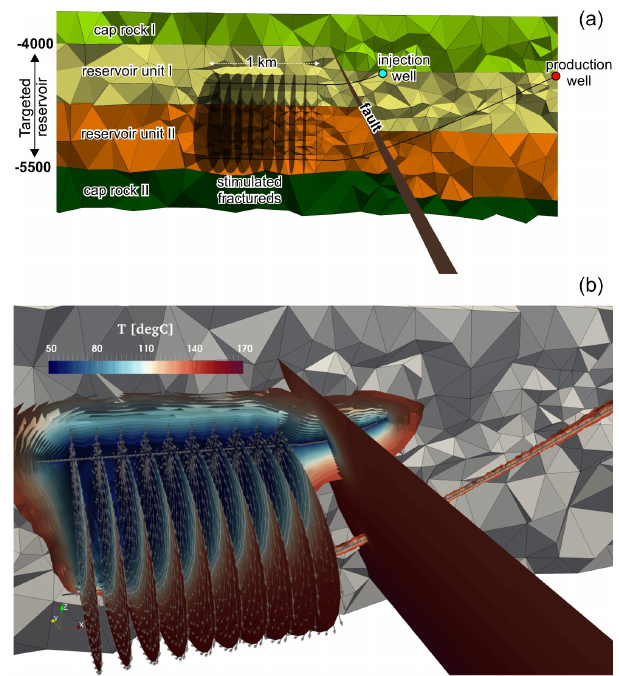
Figure 9. Problem formulation and results of the prototype of multi- fractured geothermal reservoir. Panel (a) shows the geometry and setup of the simulation and panel (b) the distribution of the temper- ature after approximately 100 years of